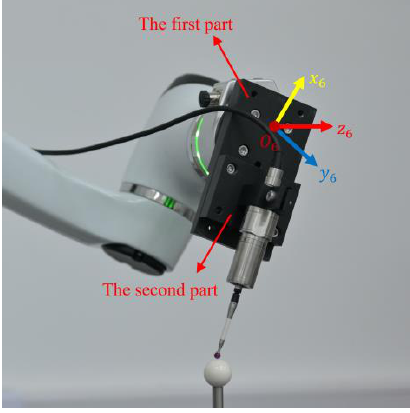
Figure 4. Special fixture.